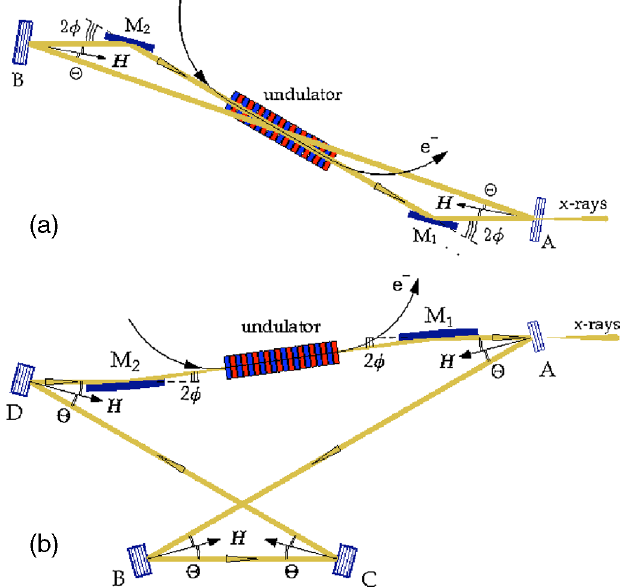
FIG. 4. X-ray cavity schemes. Part (a) uses two crystals to trap the radiation and two grazing incidence mirrors to provide focusing and angular collimation. The x-ray FEL oscillator can be made tunable by using four crystals as shown in (b). The angle of incidence (cid:1) can be varied while simultaneously adjust- ing the cavity length to change the photon energy while keeping the round-trip time fixed.